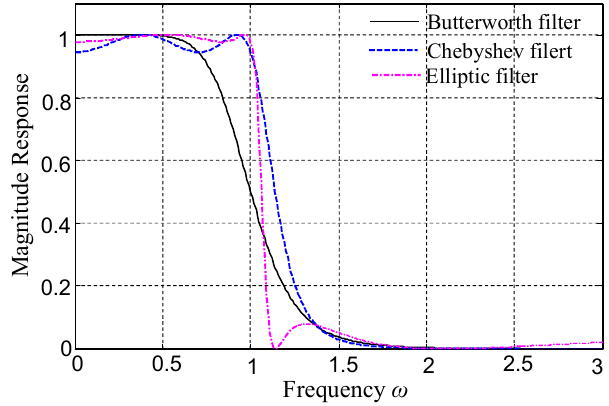
Figure 4. Frequency response characteristics of the Elliptic filter, Chebyshev filter, and Butterworth filter.